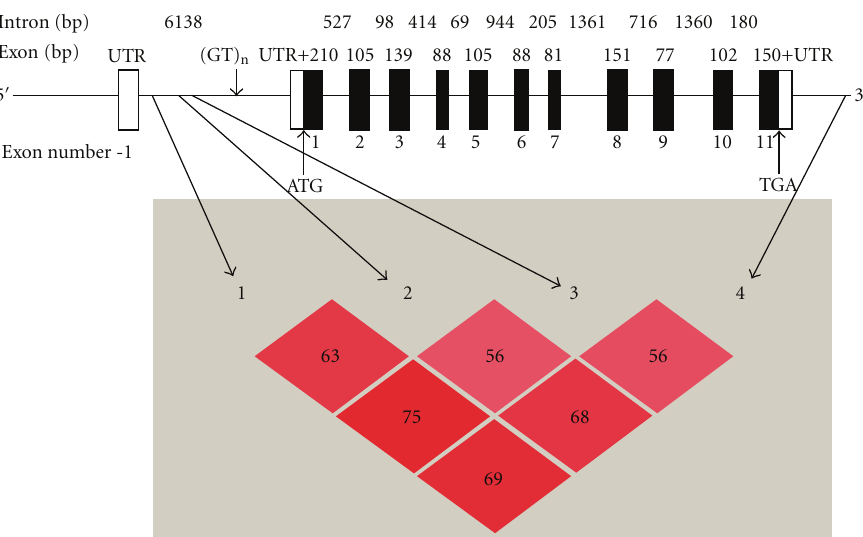
Figure 2: Schematic structure of the human Foxp3 gene and the linkage disequilibrium as determined in the URSA population (Haploview 4.20 version). The coding sequences, noncoding sequences and the introns were depicted as black boxes, white boxes, and horizontal lines, respectively. Exon numbers were shown below the exon boxes. The sizes of exons and introns were labeled above them. The locations of rs5902434 (1), rs3761548 (2), rs2232365 (3), rs2294021 (4), (GT)n microsatellite polymorphisms, the start cordon, and the stop cordon were indicated by arrows. The standard (D/LOD) was represented by red color and r 2 was presented as a number if it deviates from